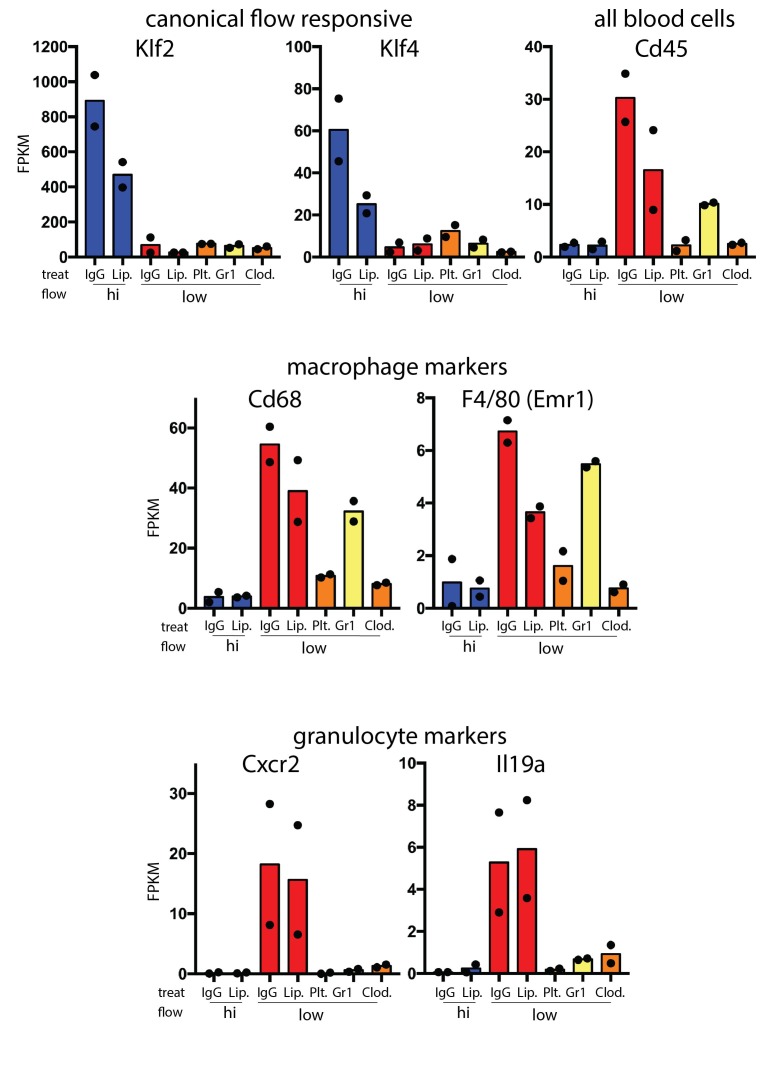
Hematopoietic cell depletion in aortic intima 48 hr after induction of low and disturbed flow.Comparison of RNA-seq data from carotid intima 48 hr after induction of low and disturbed flow, or in the contralateral arteries. Each point represents pooled RNA from multiple intimal preparations (N = 2 pools per condition, each a pool of 3–5 arteries). IgG is a non-specific antibody control for platelet (Plt.) and granulocyte (Gr1)-depleting antibodies. PBS liposome (Lip.) is a control for macrophage-depleting clodronate liposomes (Clod.).